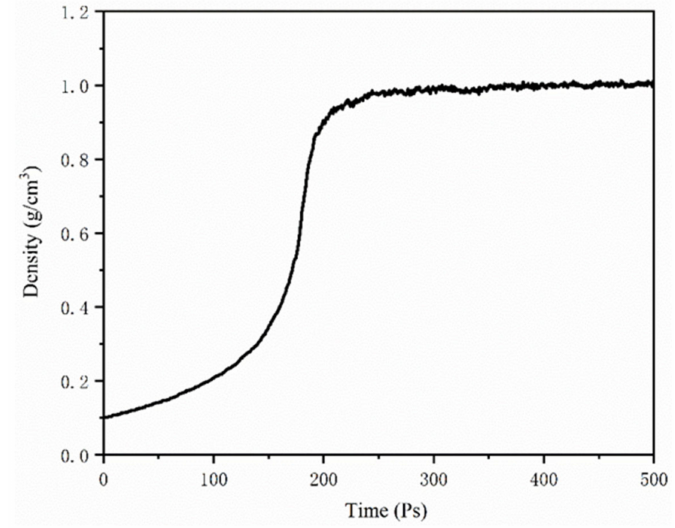
Figure 7. Densities of 4-component asphalt